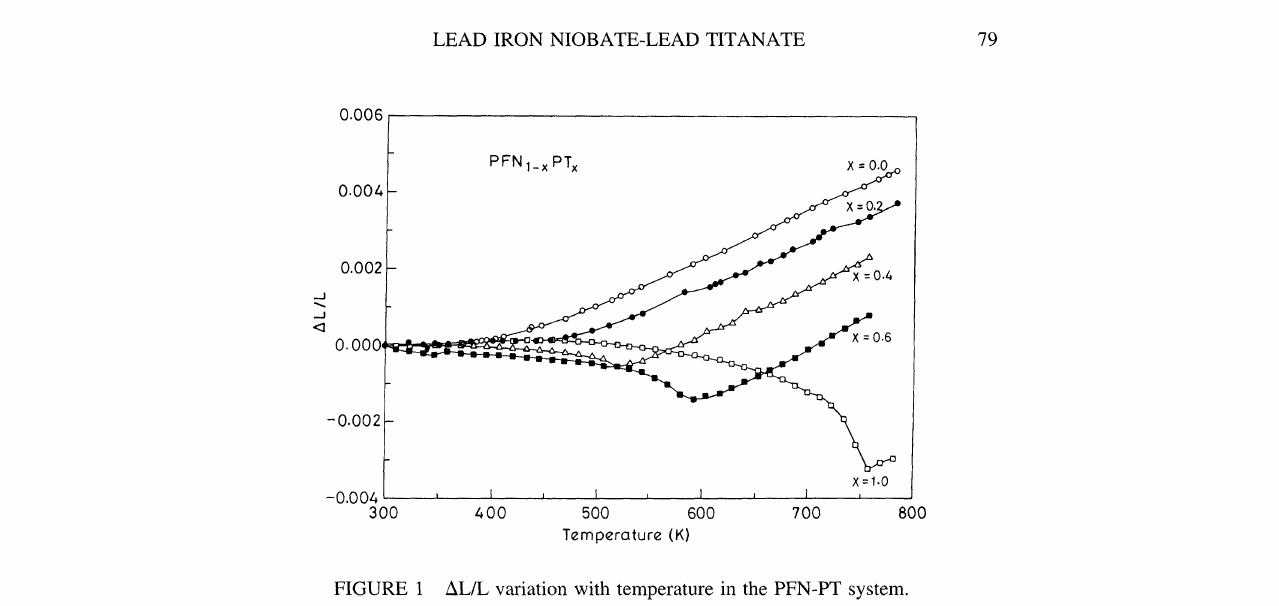
FIGURE AL/L variation with temperature in the PFN-PT